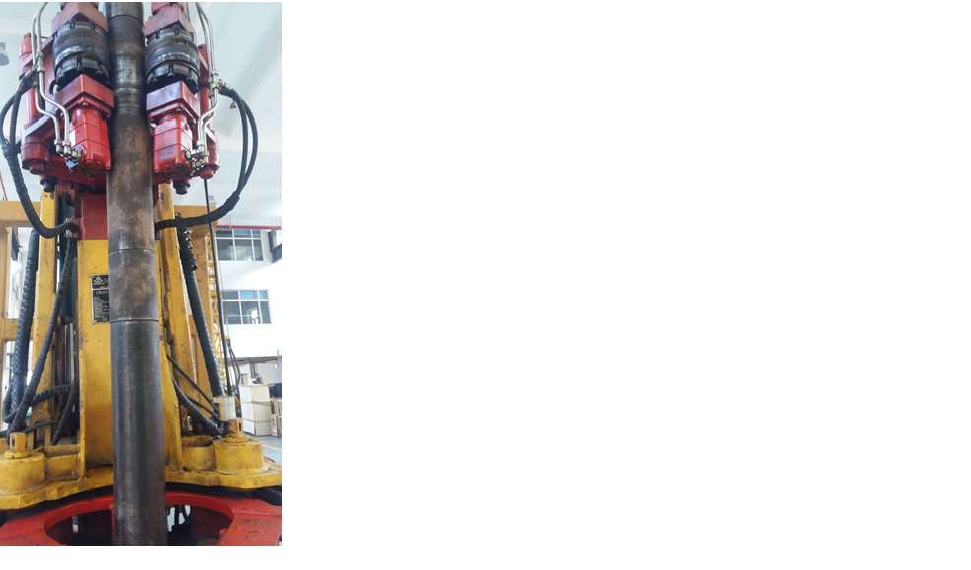
Figure 11. Experiment involving the spinner mechanism with double follow-up rollers.